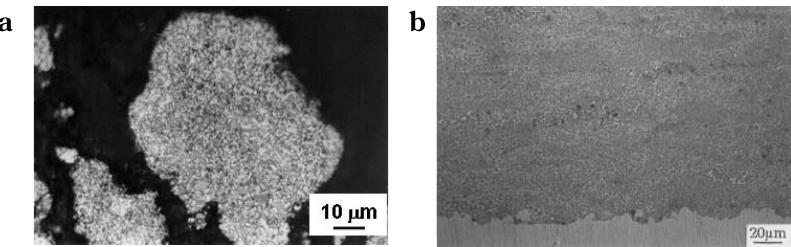
Fig.9 Cross-sections of NiCr / TiC powder (a) and LPPS coating from it